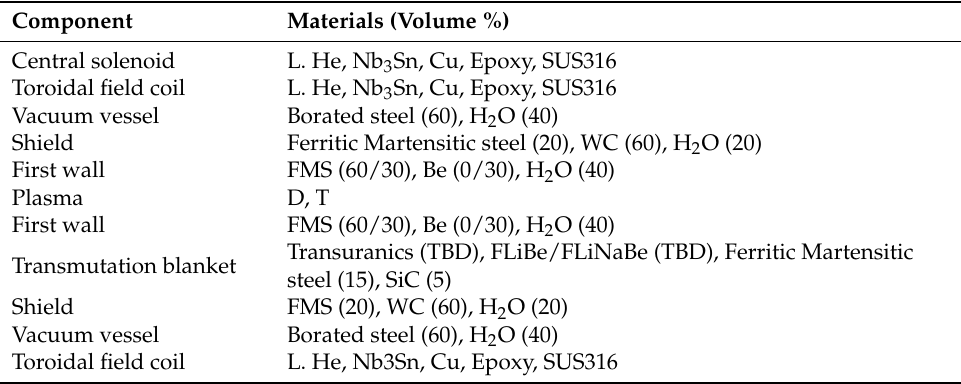
Figure 1. Transmutation reactor model in one-dimensional cylindrical geometry. Table 1. The reactor’s radial components and material